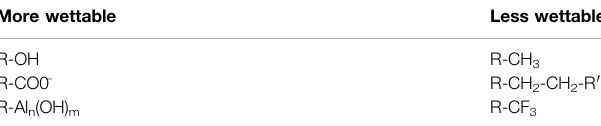
TABLE 3 | Common functional groups contributing to